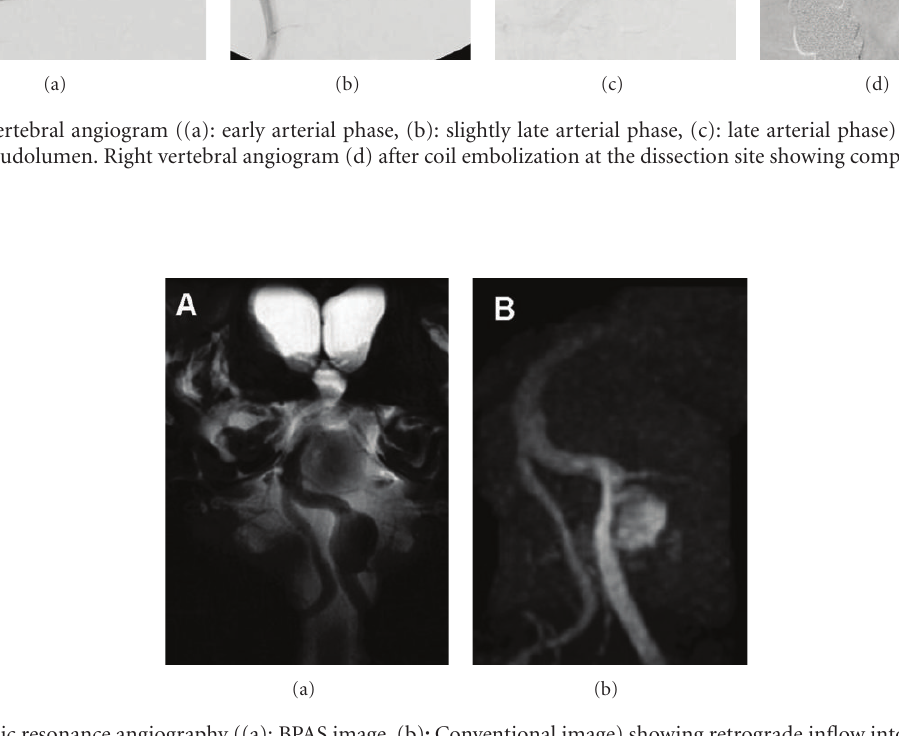
Figure 3: Magnetic resonance angiography ((a): BPAS image, (b) : Conventional image) showing retrograde inflow into the pseudolumen.